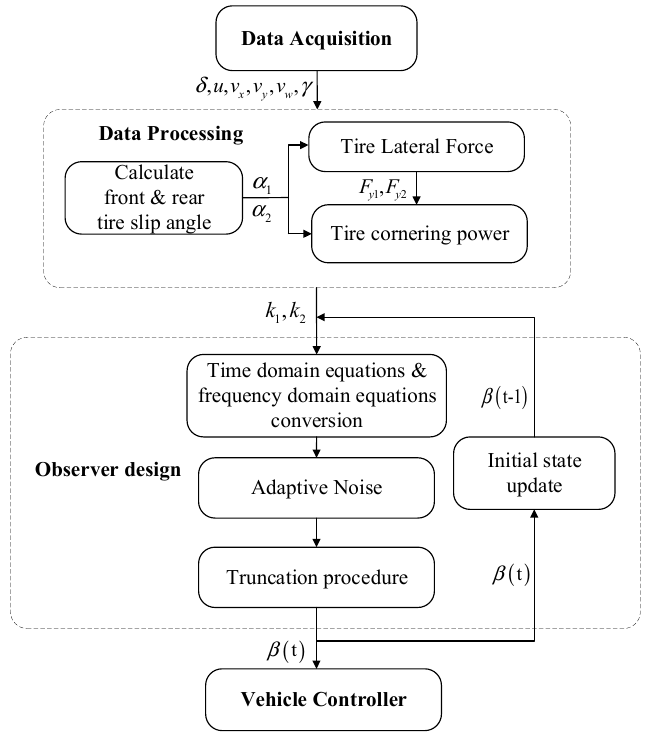
Figure 2. Algorithm flow chart.